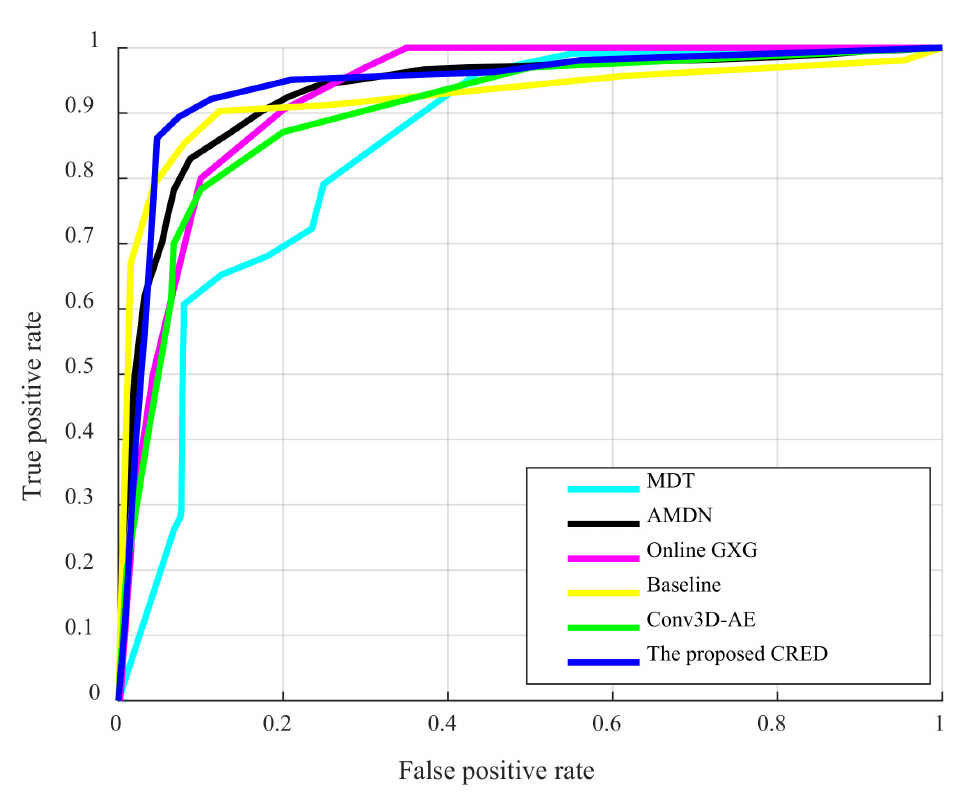
Figure 6. ROC curves for the UCSD Ped2 dataset.